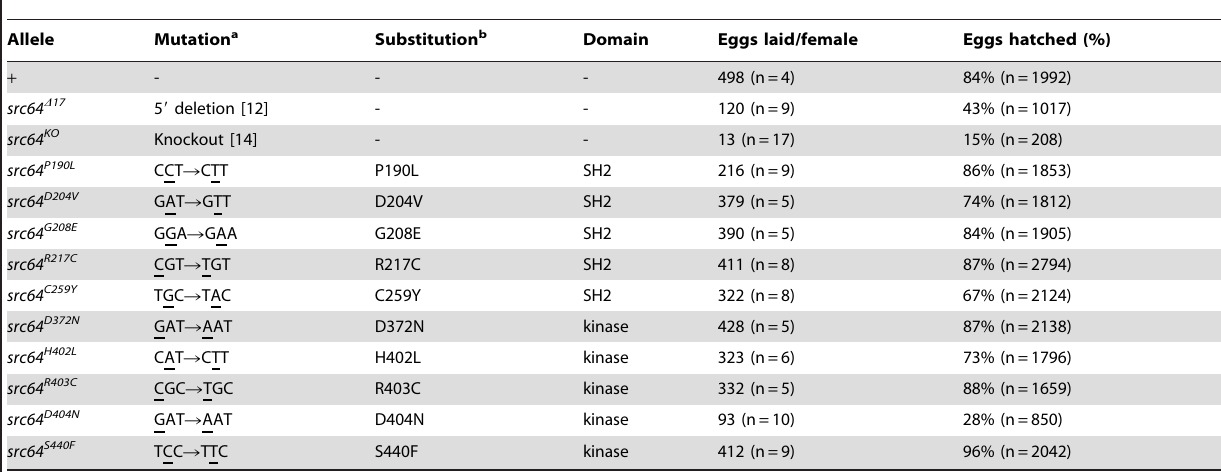
Table 1. src64 mutations and fertility of src64 KO trans -heterozygous